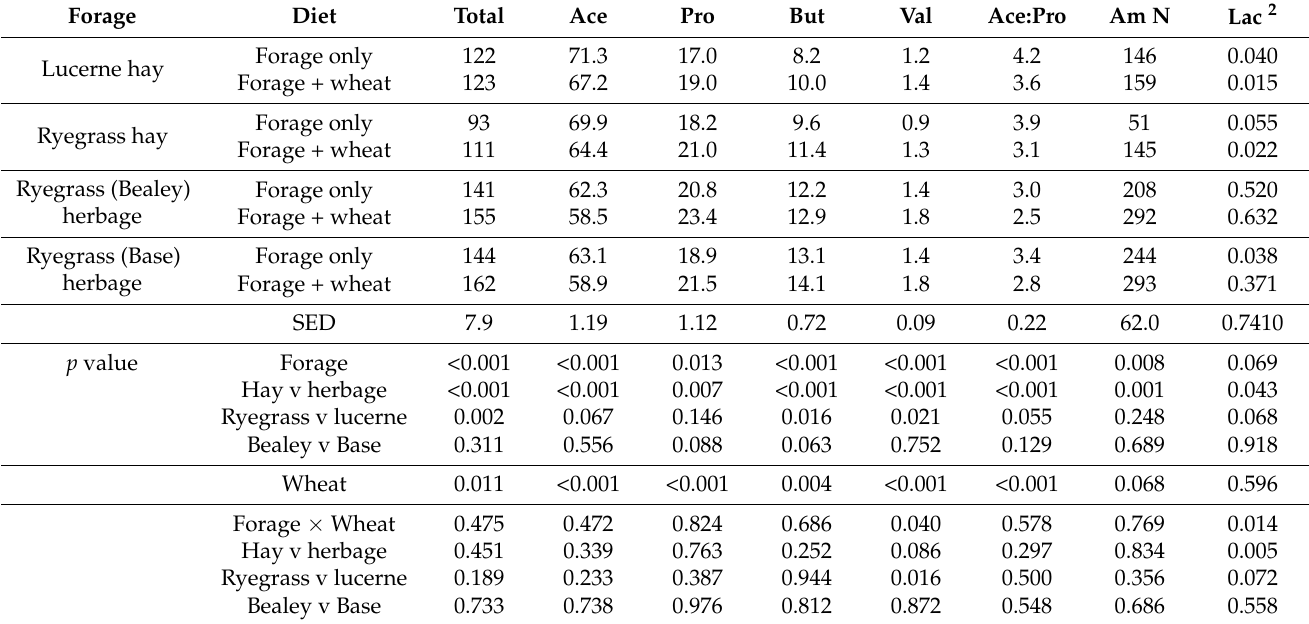
Table 5. Influence of forage type and the addition of wheat to the diet on mean concentrations in ruminal fluid of total volatile fatty acids (Total) and acetic acid (Ace), propionic acid (Pro), butryric acid (But) and valeric acid (Val; all in mmol/L), as well as ammonia N (Am N; mg/L) and D/L-lactate (Lac; mmol/L) 1 . Forage